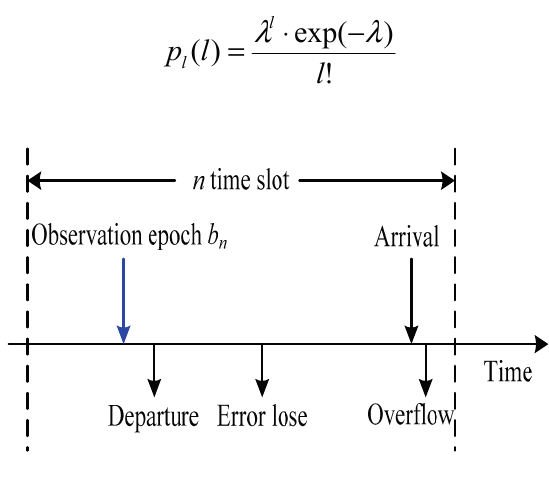
Figure 4. Buffer timing